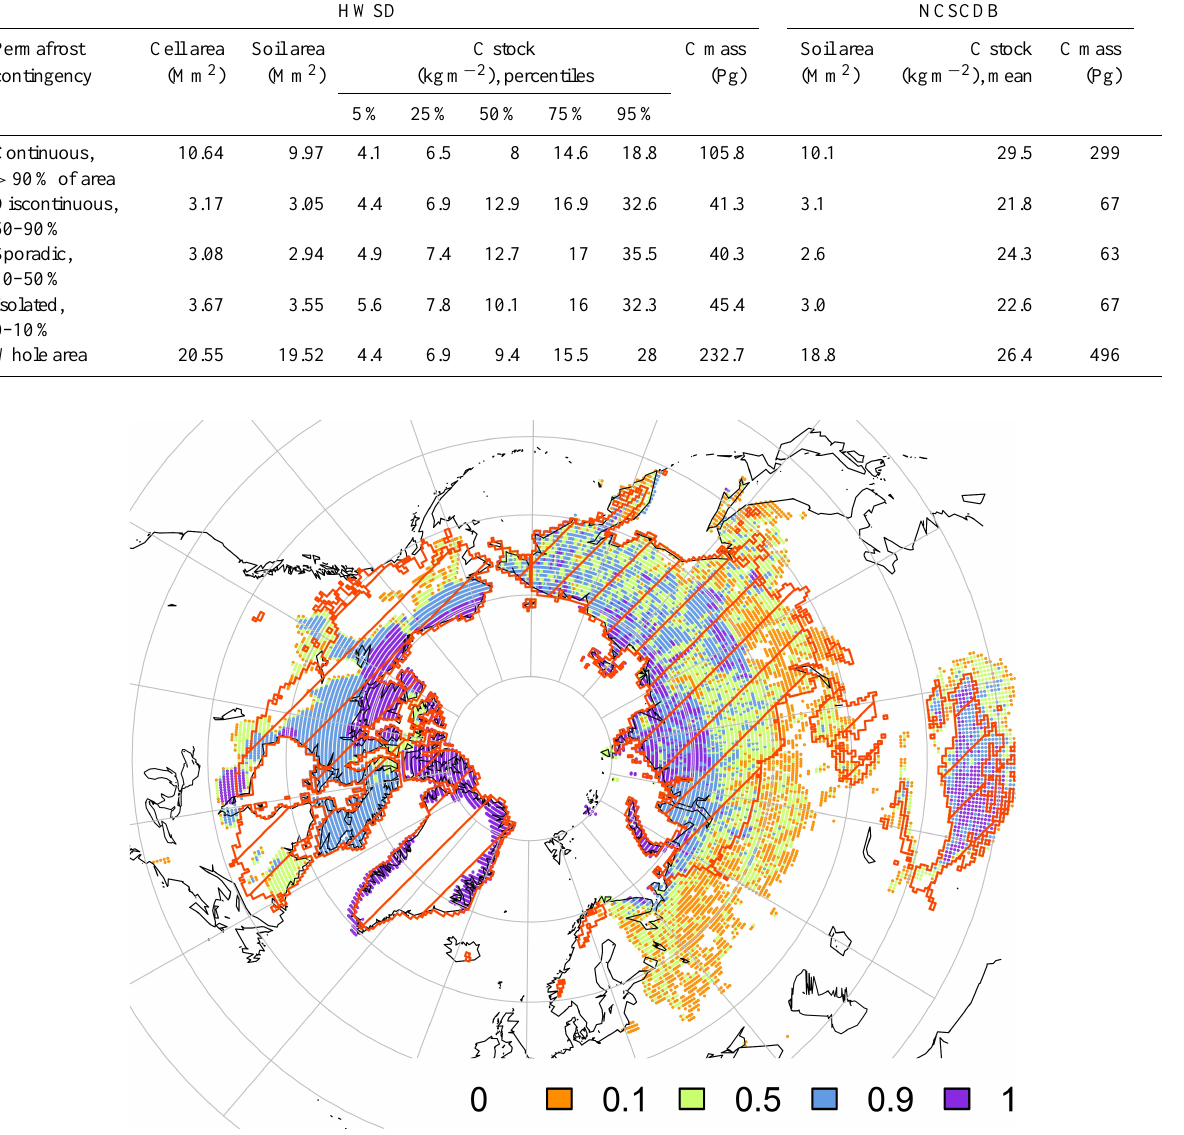
Figure 2. Extent of permafrost in HWSD v.1.1. Color scale: fraction of soil units within a 0.5 (cid:48) grid cell with “gelic phase” (averaged for display to 0.5 ◦ resolution); red outline: permafrost attribute in HWSD supplementary data sets SQ1–7 at 5 (cid:48)